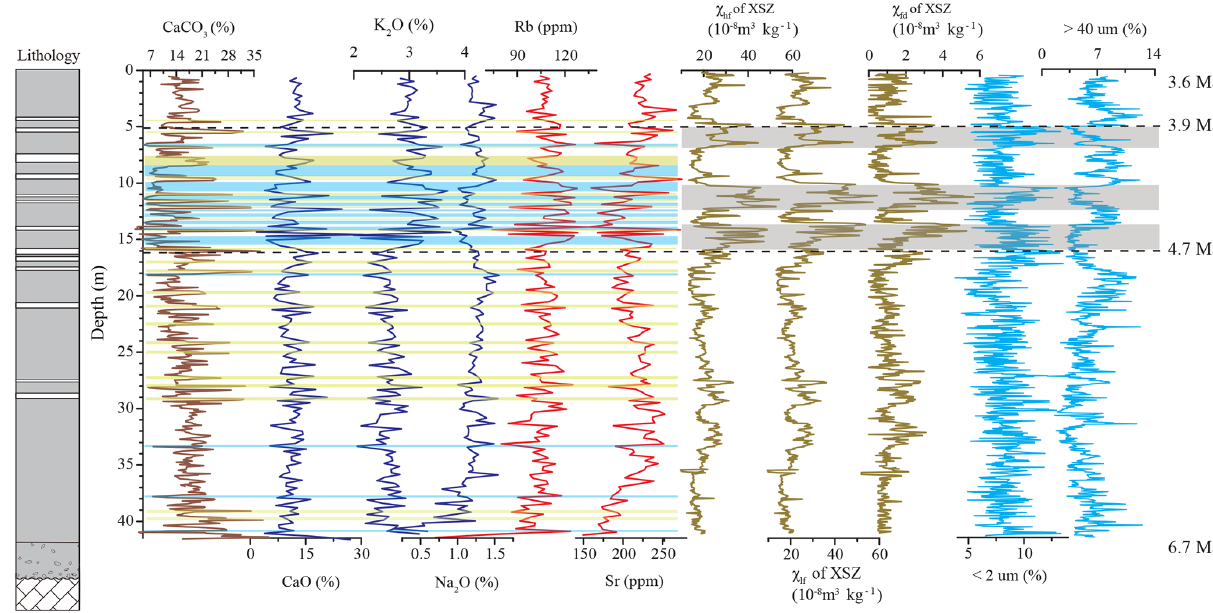
Figure 3. Variations in carbonate content, major element concentration, minor element concentration, magnetic susceptibility, and grain size for the XSZ red clay section (6.7–3.6Ma). Yellow shading indicates B k horizons with carbonate content >21%; blue shading indicates B w horizons with carbonate content <8%; gray shading indicates intervals with high magnetic susceptibility. Dashed lines are upper and lower boundaries of the relatively wet